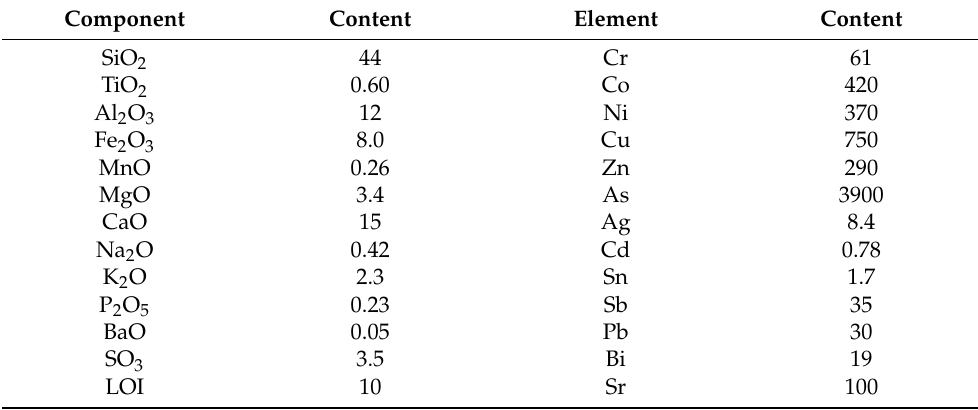
Table 2. Composition of solid tailings (sample KhA tot ): SiO 2 –LOI in % and Cr–Sr in ppm.